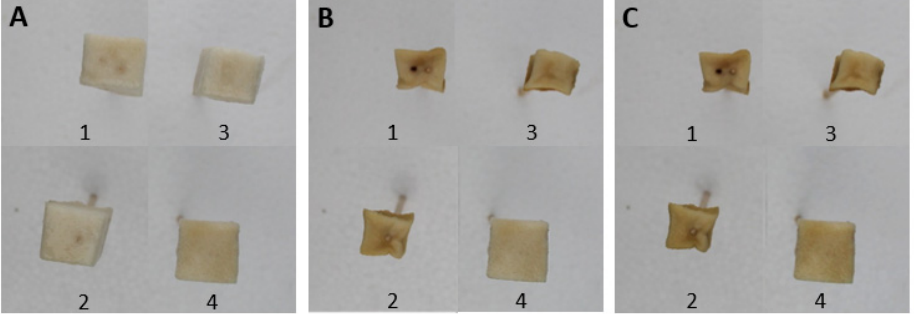
Figure 5. The visual appearance of cherimoya pieces after coating treatments during storage at 0 (panel A ), 7 (panel B ), and 10 days (panel C ). 1, UC; 2, SC-A; 3, SC-B; 4, MC.